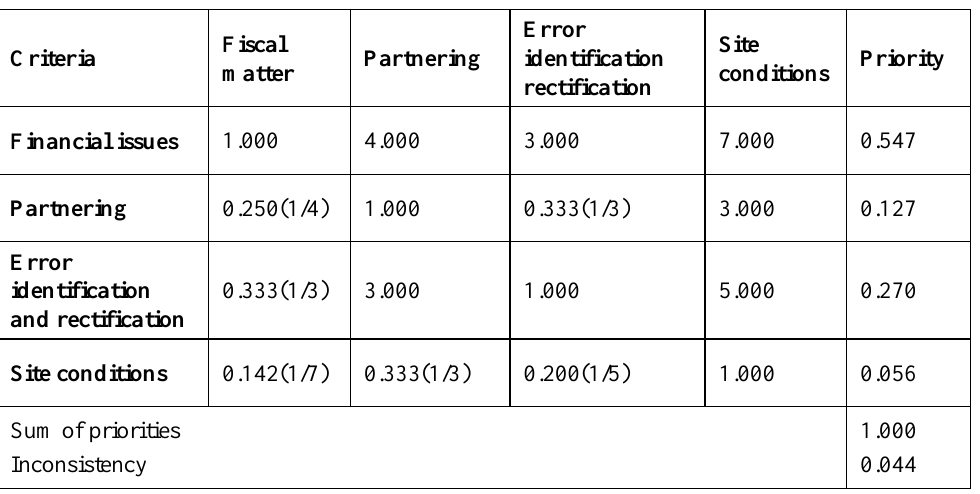
Table 6. Results of Criteria